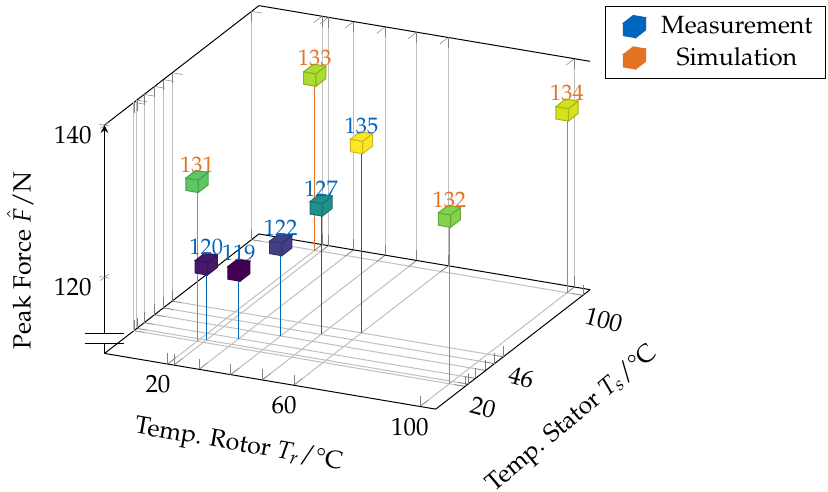
Figure 14. Increase of measured and simulated peak force values over different combinations of temperatures in rotor and stator. The simulation can show the qualitative effect compared to the measured values but less